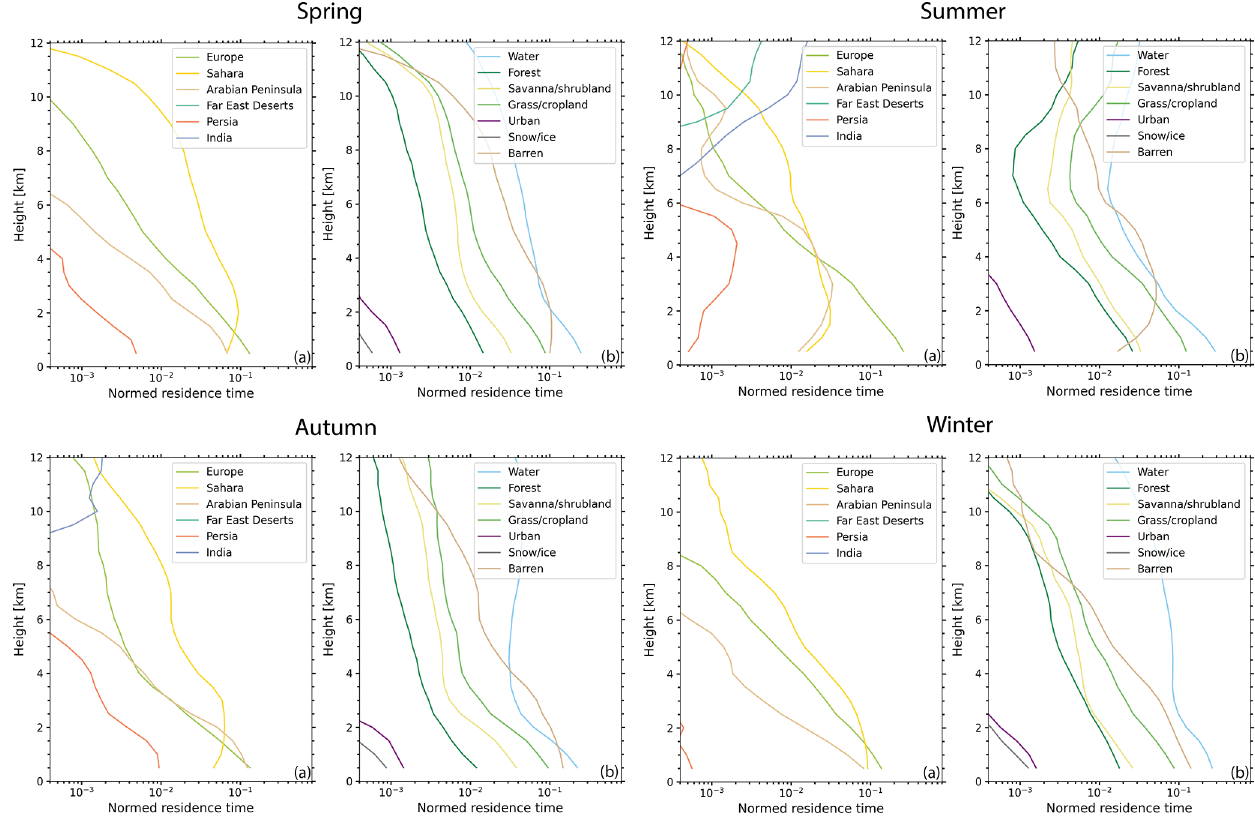
Figure 9. Air mass source estimate based on FLEXPART particle positions for the Haifa station for March, April, and May (spring season) 2017–2019 (upper left); for June, July, and August (summer season) 2017–2018 (upper right); for September, October, and November (autumn season) 2017–2018 (lower left); and for December, January, and February (winter season) 2017–2019 (lower right). The named geographical areas (a) and the land surface classification (b) are only for the periods with available lidar data (sub-sampled). The reception height threshold is